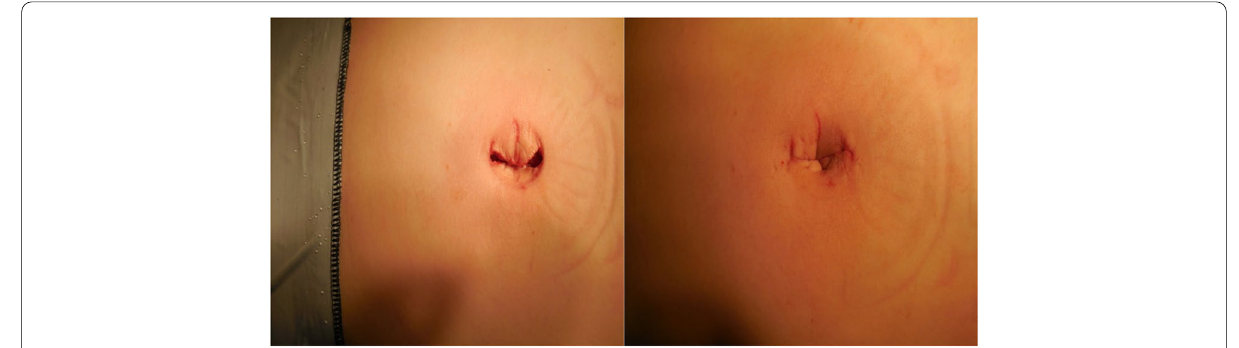
Fig. 5 Transumbilical incision (left) and after closure